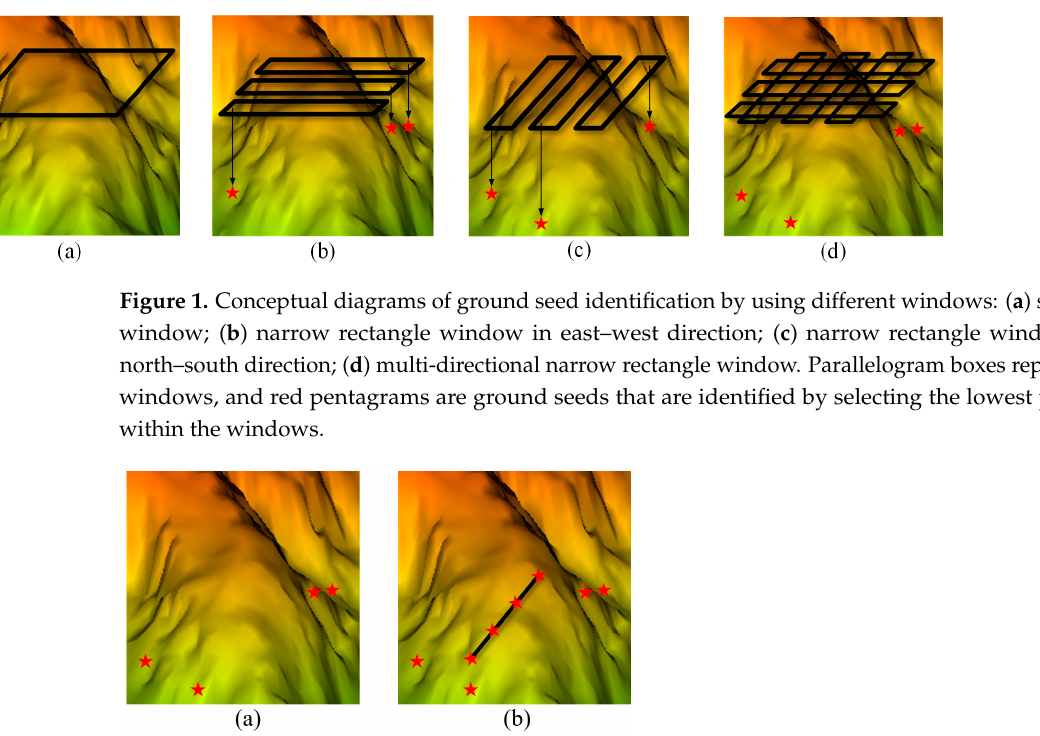
Figure 2. Ground seed enhancement with line segmentation. Ground seeds identified only using the method ( a ) without and ( b ) with line segmentation. Ground seeds can be supplemented on raised terrain, where it is difficult for ground seeds to be identified by selecting the lowest points within the windows. Black lines and red pentagrams represent line primitives and ground seeds, respectively.